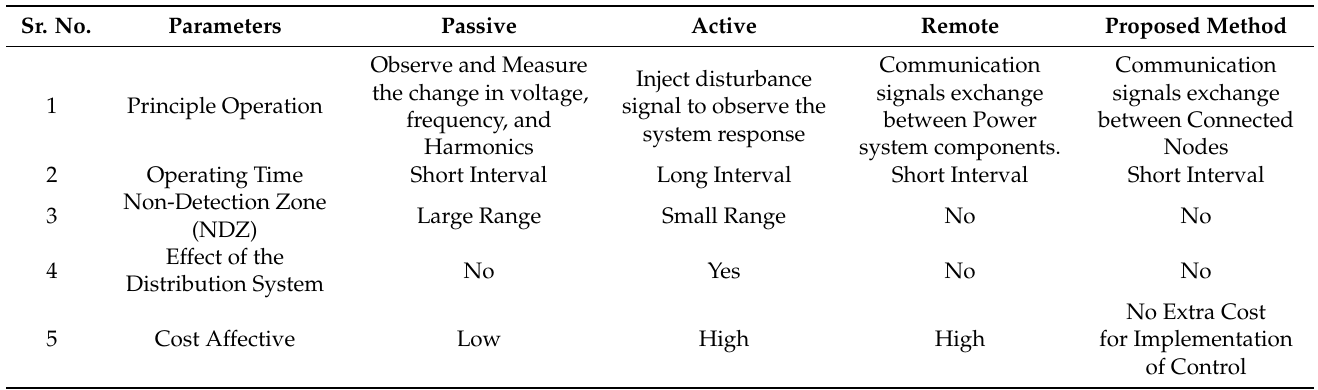
Table 5. Comparison between Islanding Detection Methods